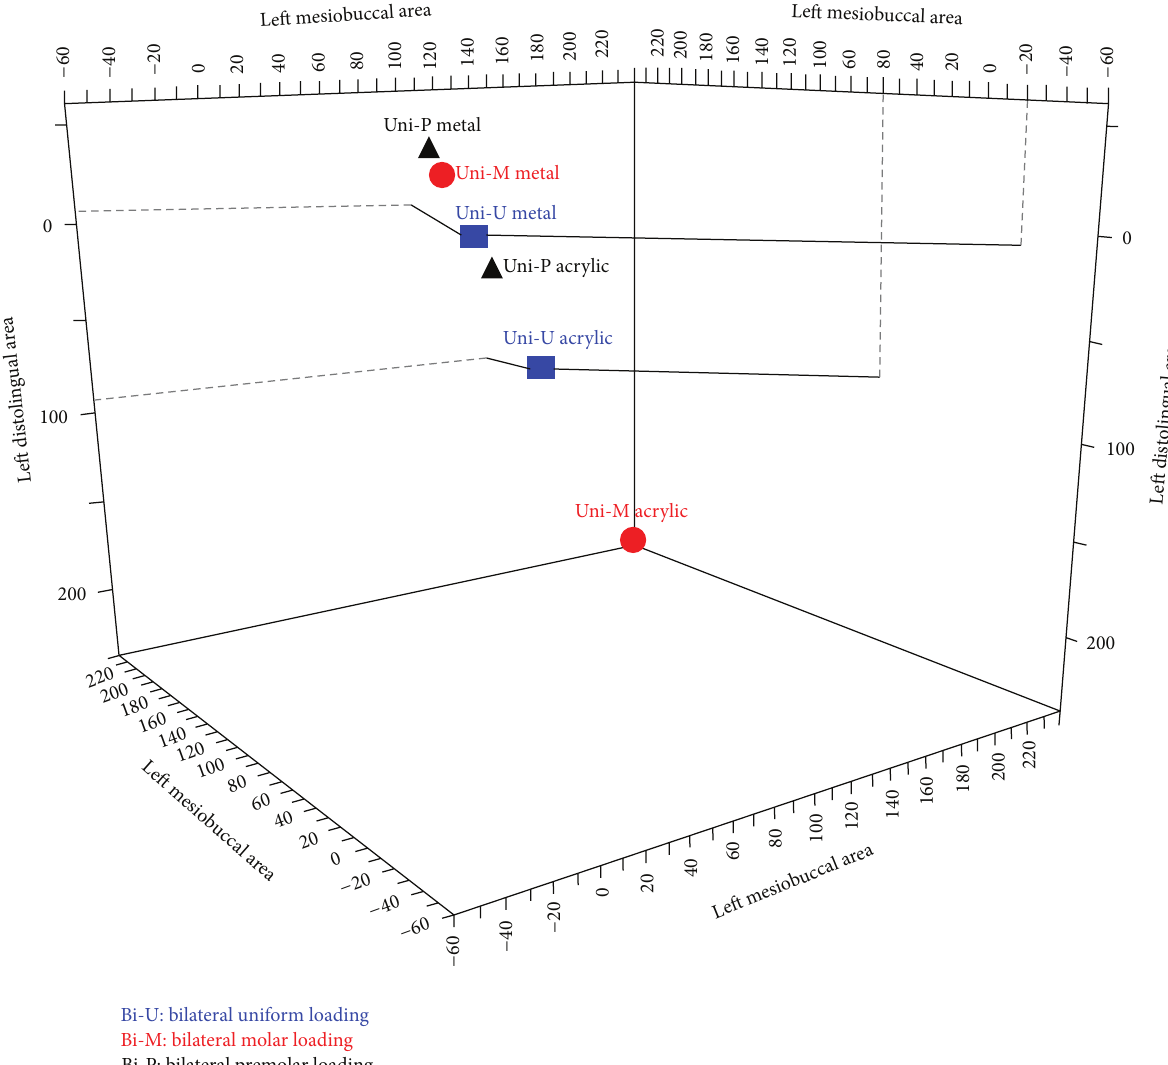
Figure 7: Comparison of microstrain values in both metal framework and acrylic base (unilateral loading conditions).